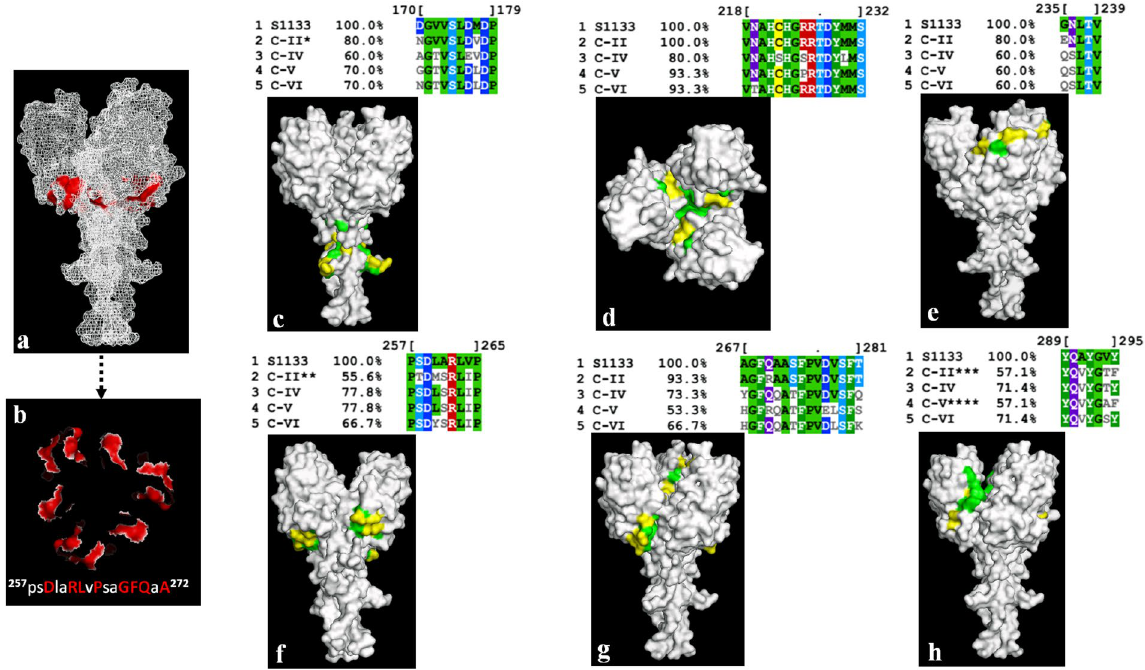
Figure 8. Conserved and variable regions of predicted antigenic epitopes of the Sigma C protein shown on the modelled Sigma C carboxy terminus receptor binding domain trimeric structure. ( a and b ) Conserved proposed receptor binding residues. The conserved residues are highlighted in red as “cartoons”. ( c to h ) The conserved amino acid residues on the predicted antigenic epitopes between the S1133 vaccine strain and our isolates which grouped into different cluster “C” groups are shown in green as “surface” on the carobxy terminus receptor binding domain model structure of the Sigma C protein. The variable regions are shown in yellow. * 194 DV substituted by 194 VM, ** 260 M substituted by I, *** 294 T substituted by N or A and **** 294 A substituted by N or D in some